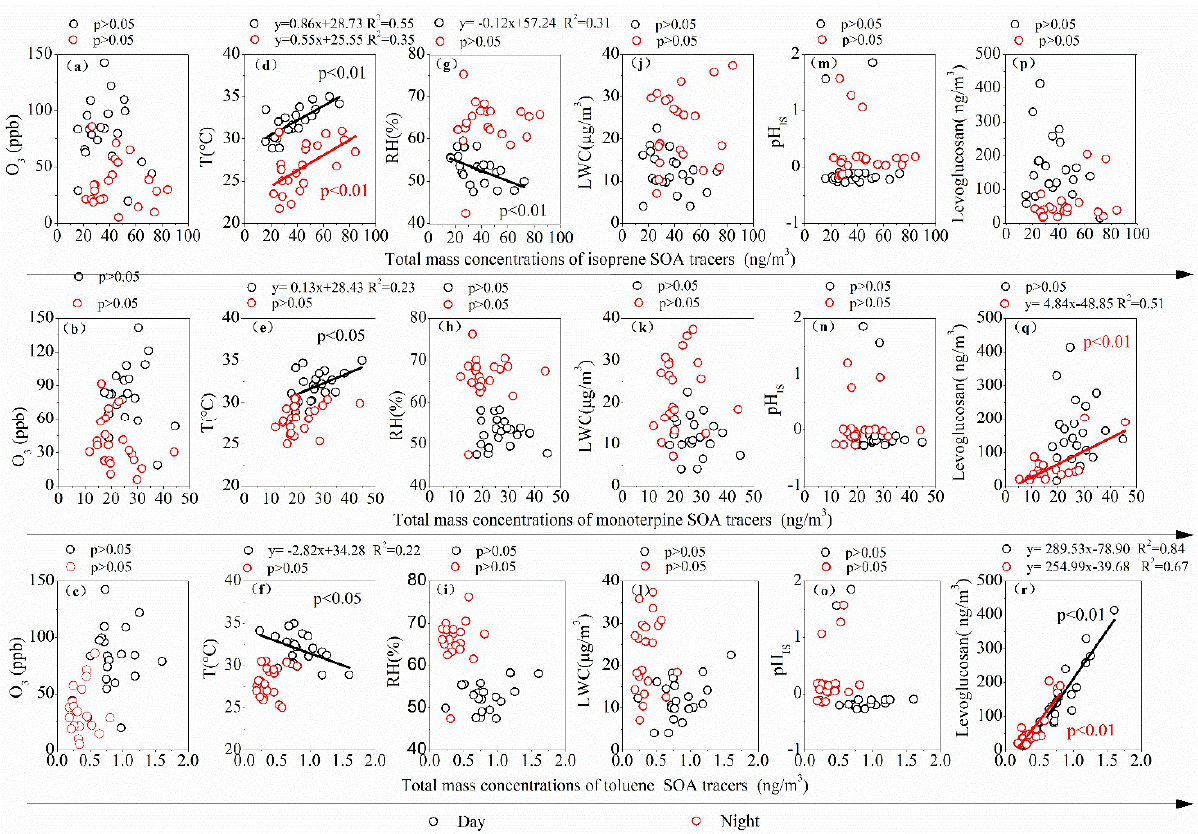
Figure 5. Linear regressions of BSOA tracers and aromatics SOA tracer with multiple parameters: ( a – c ) for O 3 , ( d – f ) for temperature (T), ( g – i ) for relatively humidity (RH), ( j – l ) for in-situ pH (pH IS ), ( m – o ) for liquid water content (LWC), and ( p – r ) for levoglucosan.